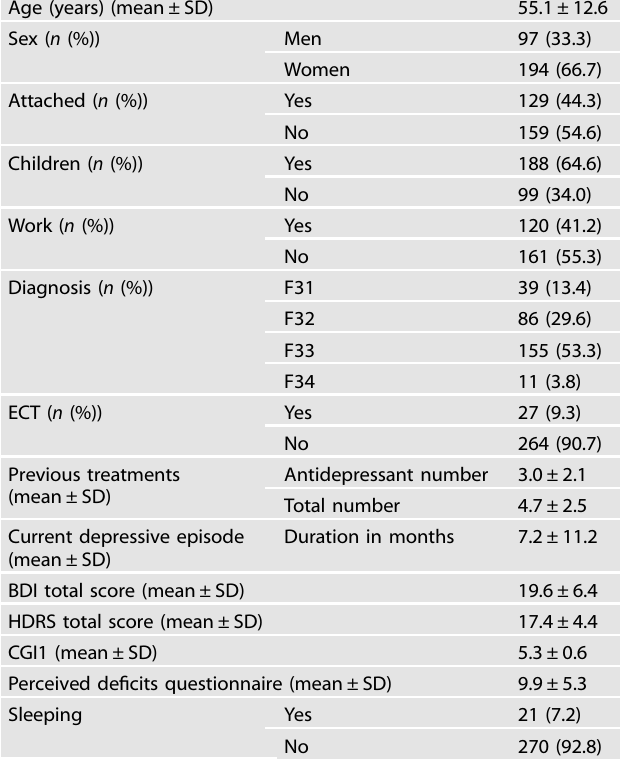
Table 1. Descriptive data at